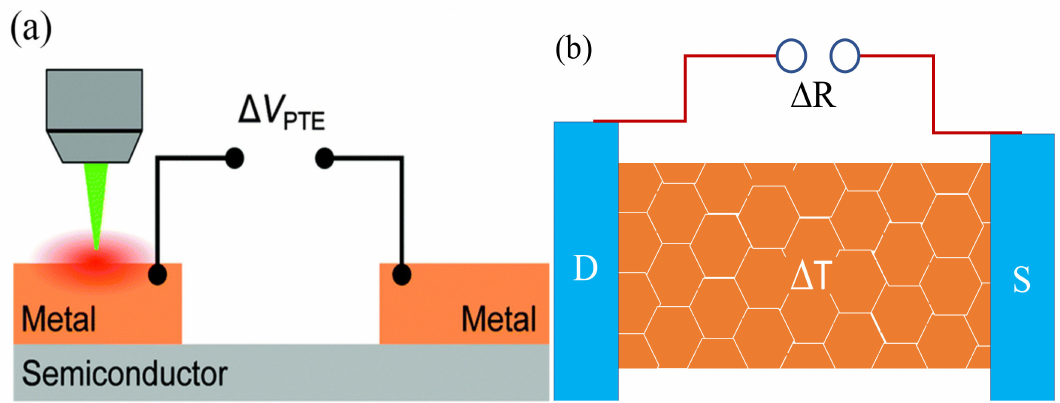
Figure 6. Photo-thermoelectric e ff ect; Schematic of a semiconductor locally illuminated by a focused laser spot on one of the metal contacts to the semiconducting channel and ( b ) Schematic illustrating photo-bolometric e ff ect. ( a ) Reproduced with permission from reference [6]. ( b ) Adapted with permission from reference